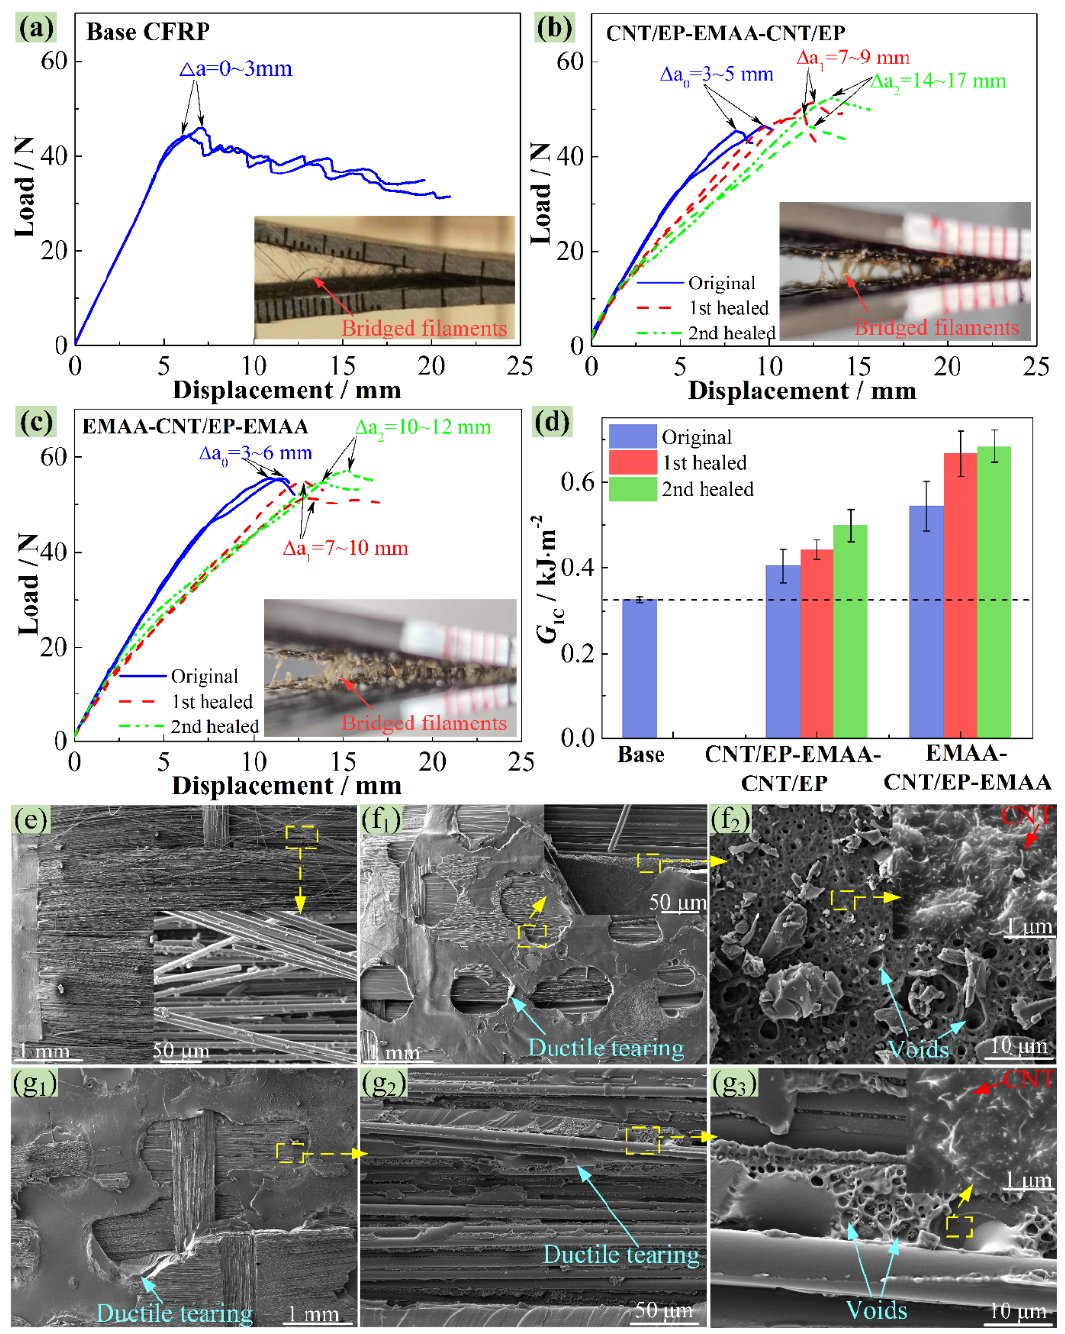
Figure 5. DCB testing results before and after self ‐ healings, load–displacement curves of ( a ) base CFRP, ( b ) CNT/EP ‐ EMAA ‐ CNT/EP CFRP and ( c ) EMAA ‐ CNT/EP ‐ EMAA CFRP, ( d ) comparison of G IC , SEM images of the fractured DCB specimens, ( e ) base CFRP, ( f 1 , f 2 ) CNT/EP ‐ EMAA ‐ CNT/EP CFRP and ( g 1 – g 3 ) EMAA ‐ CNT/EP ‐ EMAA CFRP.